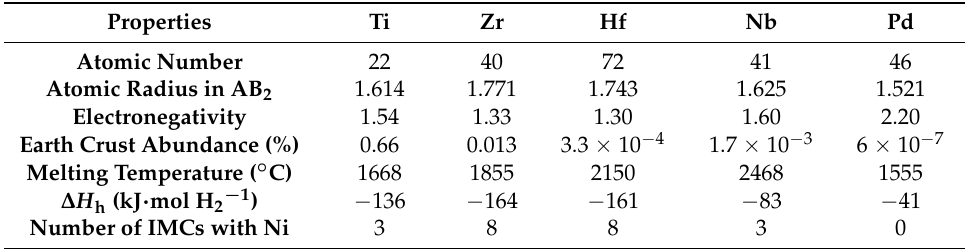
Table 5. Properties of A-site elements in AB 2 alloys. IMC denotes intermetallic